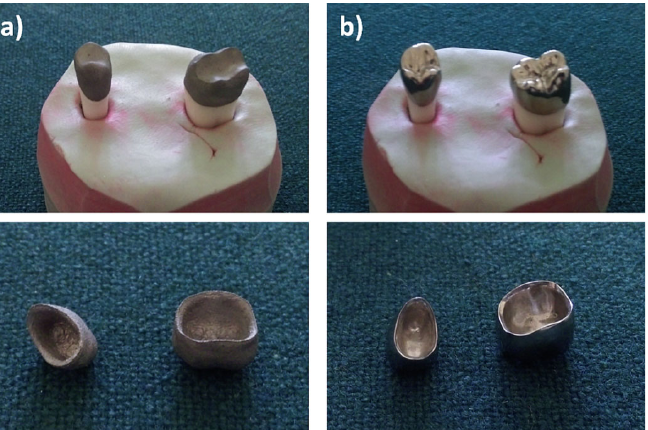
Figure 1. Reference models and crowns made of Ti6Al4V alloy for premolars and molars produced in the following technologies: ( a ) SLM, and ( b ) milling.